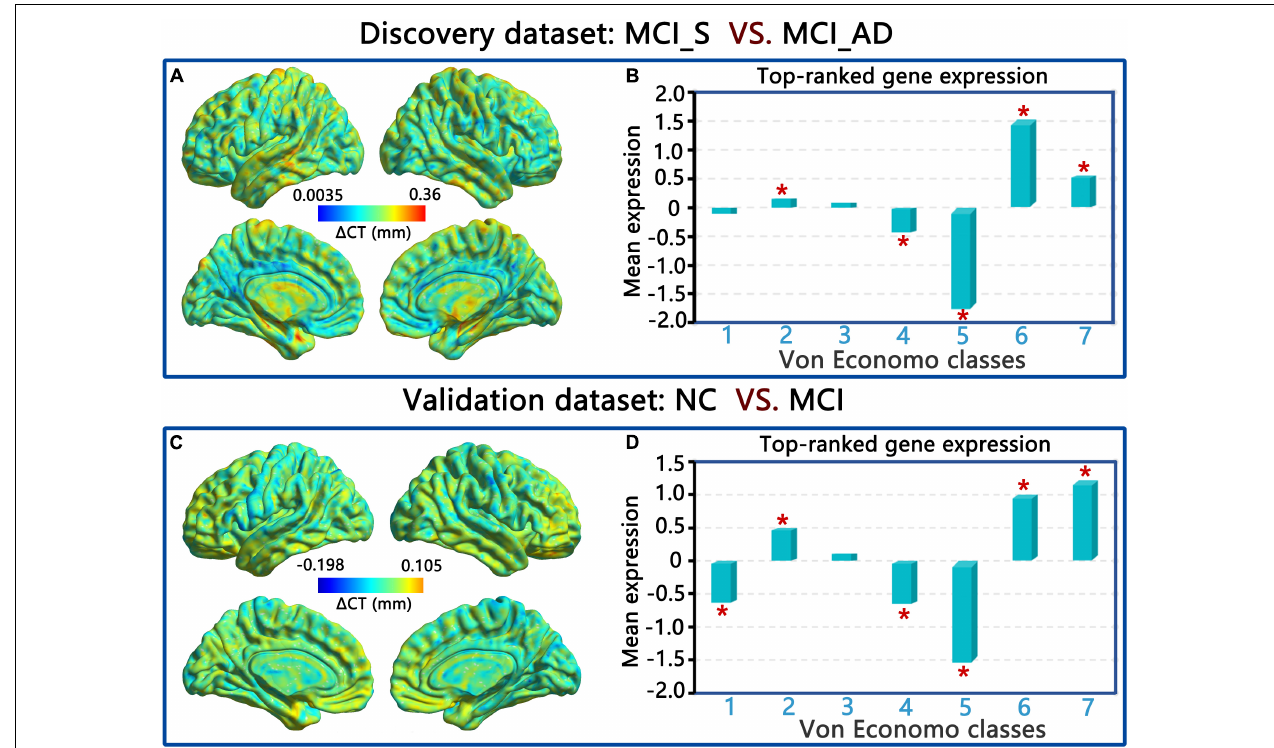
FIGURE 6 | (cid:49) CT and von Economo classes of PLS1 in the discovery dataset (A,C) , and the validation dataset (B,D) .